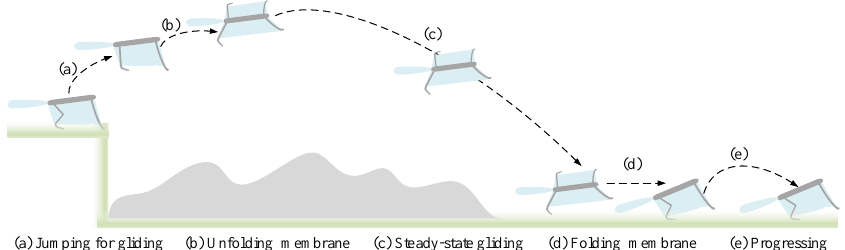
Figure 2. Locomotion conceiving of flexible wing–limb blending platform.